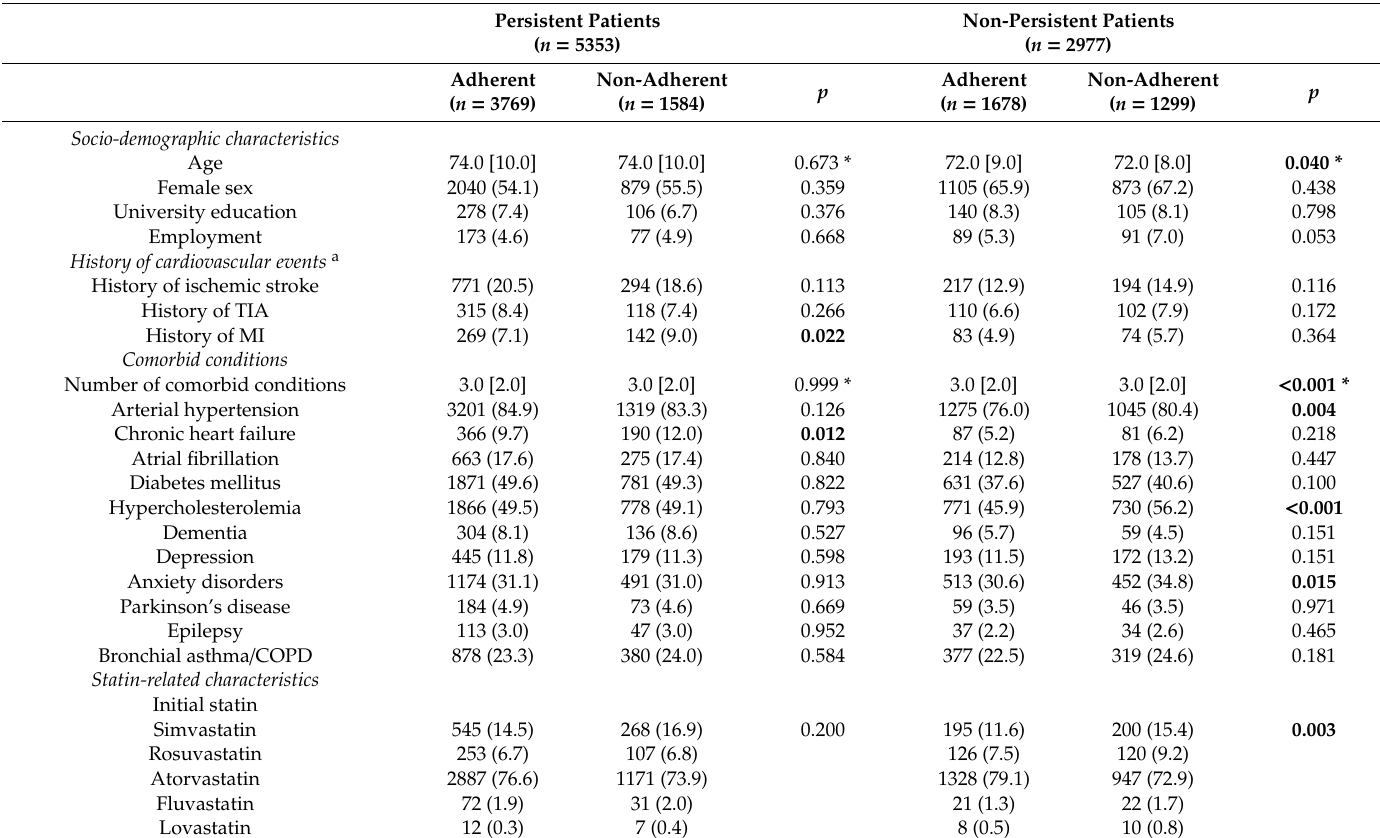
Table 1. Baseline characteristics of the study